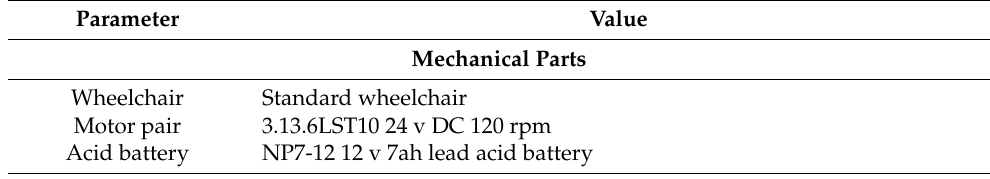
Table 3. Hardware specifications.